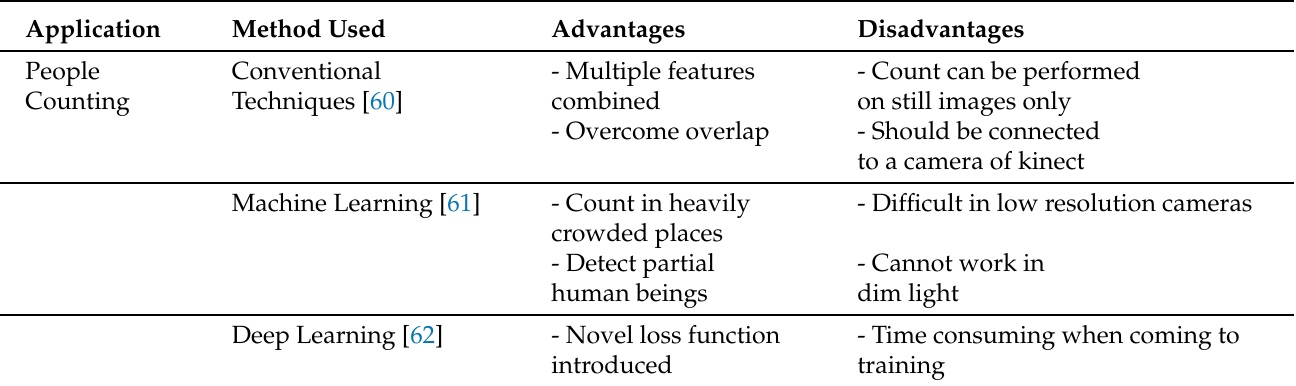
Table 5. Comparison between methods used in